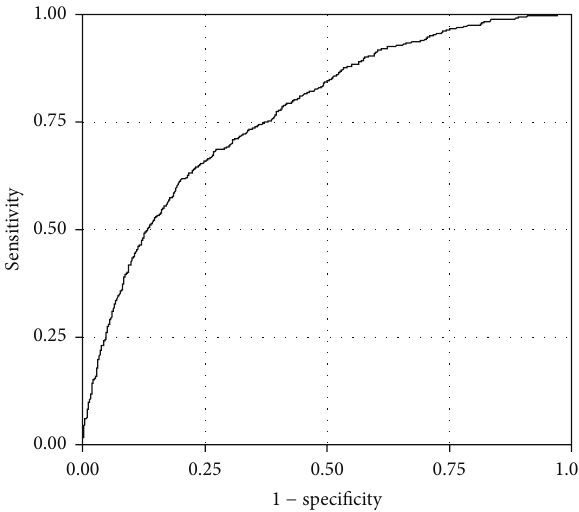
Figure3:Receiveroperatorcharacteristic(ROC)curveforaccuracy of final regression model for grades 2 and 3 steatosis versus grade 1 steatosis. The area under the curve was